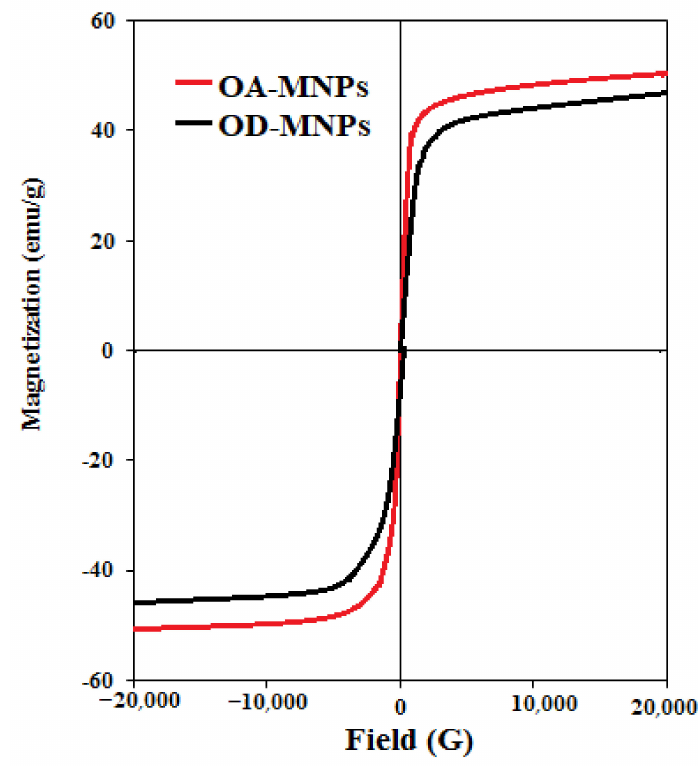
Figure 8. VSM magnetization curves of OA-MNPs and